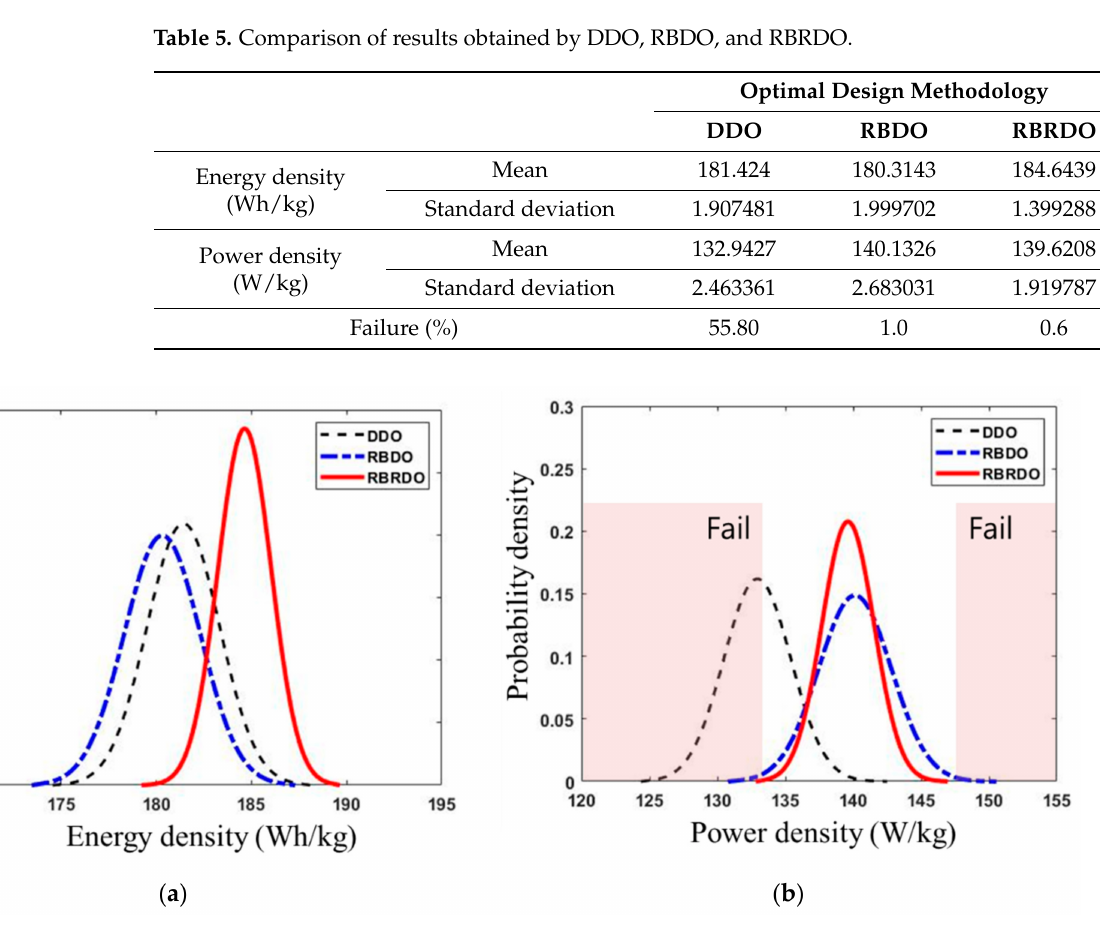
Figure 7. Comparison of results obtained by DDO, RBDO, and RBRDO for ( a ) energy density and ( b ) power